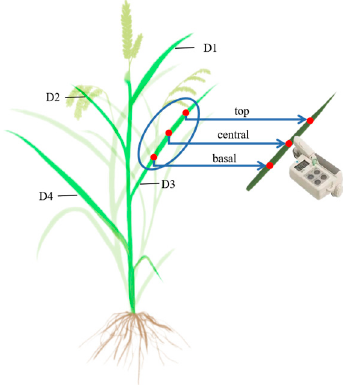
Figure 2. Schematic diagram of the determination of the relative chlorophyll content. The red dots represent the actual measuring points, namely the top, central and basal.